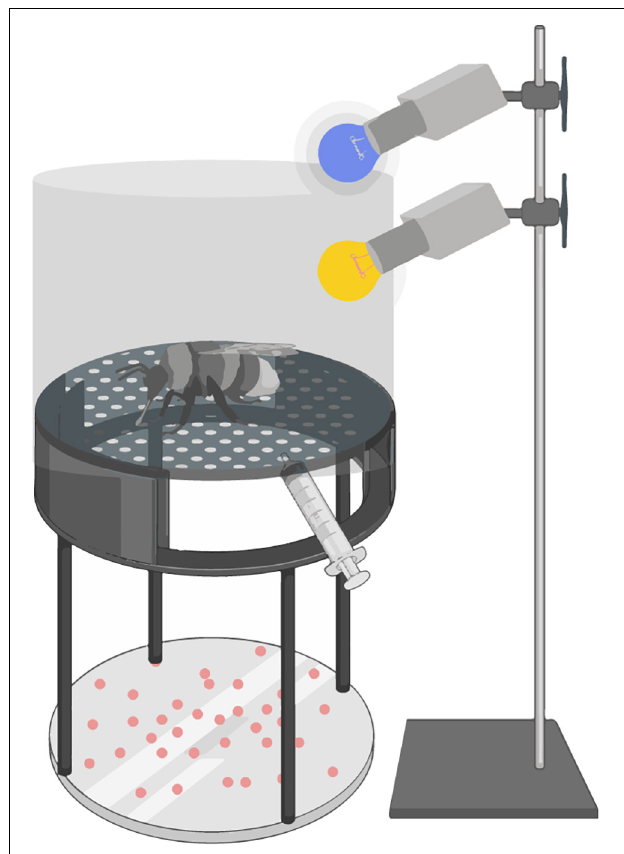
FIGURE 1 | Behavioural arena set-up. A schematic drawing of the experimental set-up used to investigate the effect of rearing temperature on the behavioural responses of bumblebees to different sensory stimuli. Bees were placed in the centre of the arena and presented with a light stimulus from above (UV or white light), an olfactory or mechanosensory stimulus delivered through a syringe from below (honey water odour or an air puff) or a drop of liquid (white sugar water or quinine) placed on the floor of the arena. Responses to these stimuli were recorded using a camera that filmed the set-up from